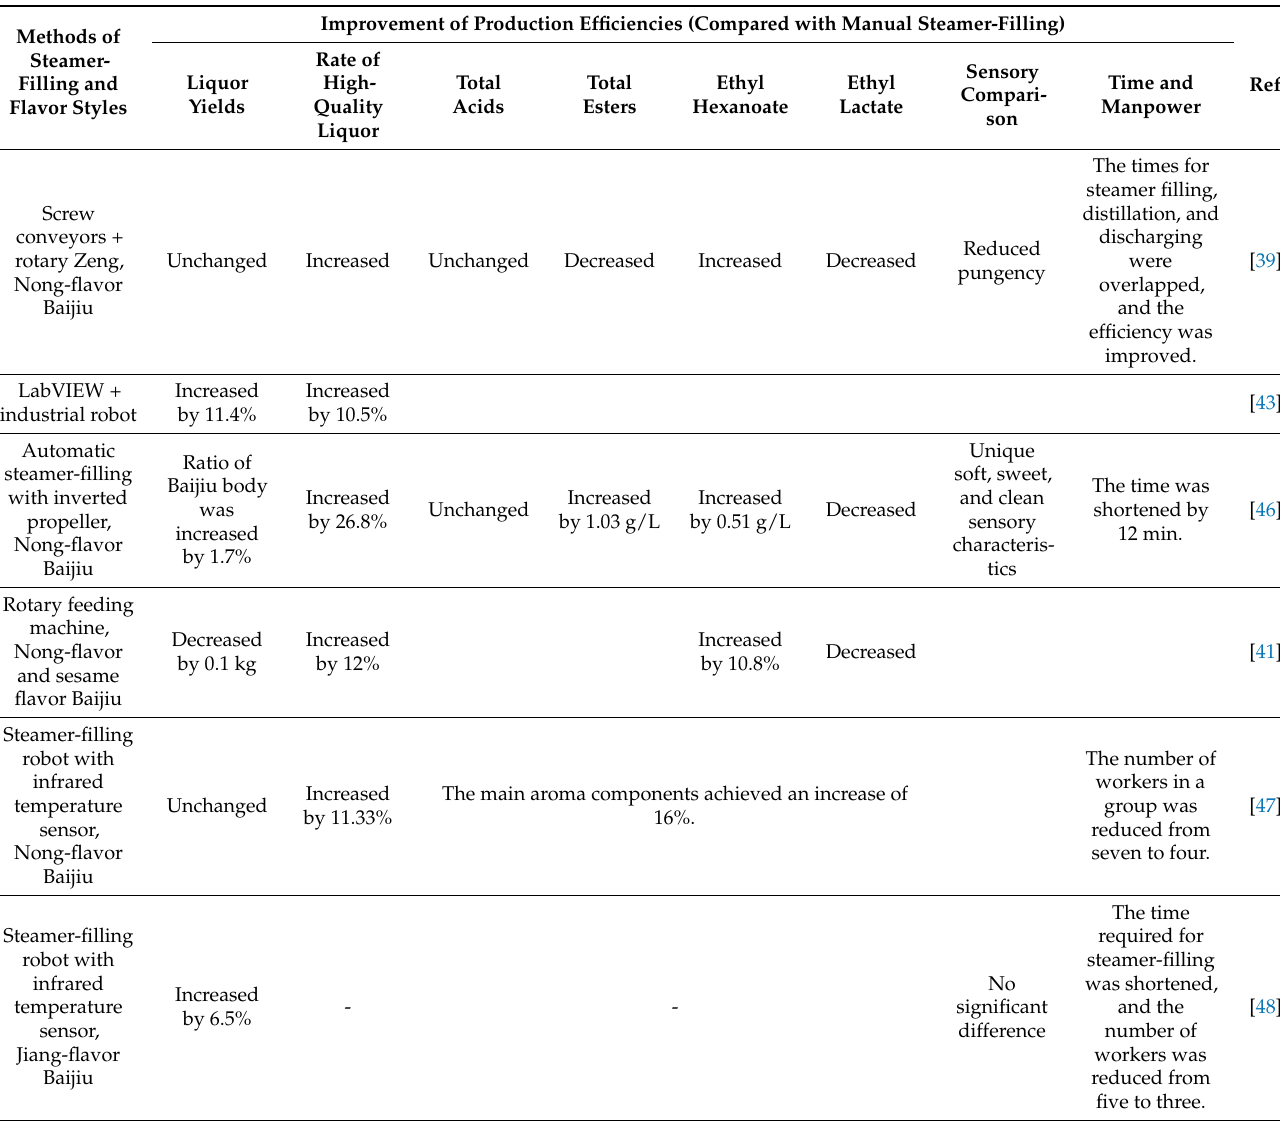
Table 1. Effect of automatic steamer-filling on the quality of